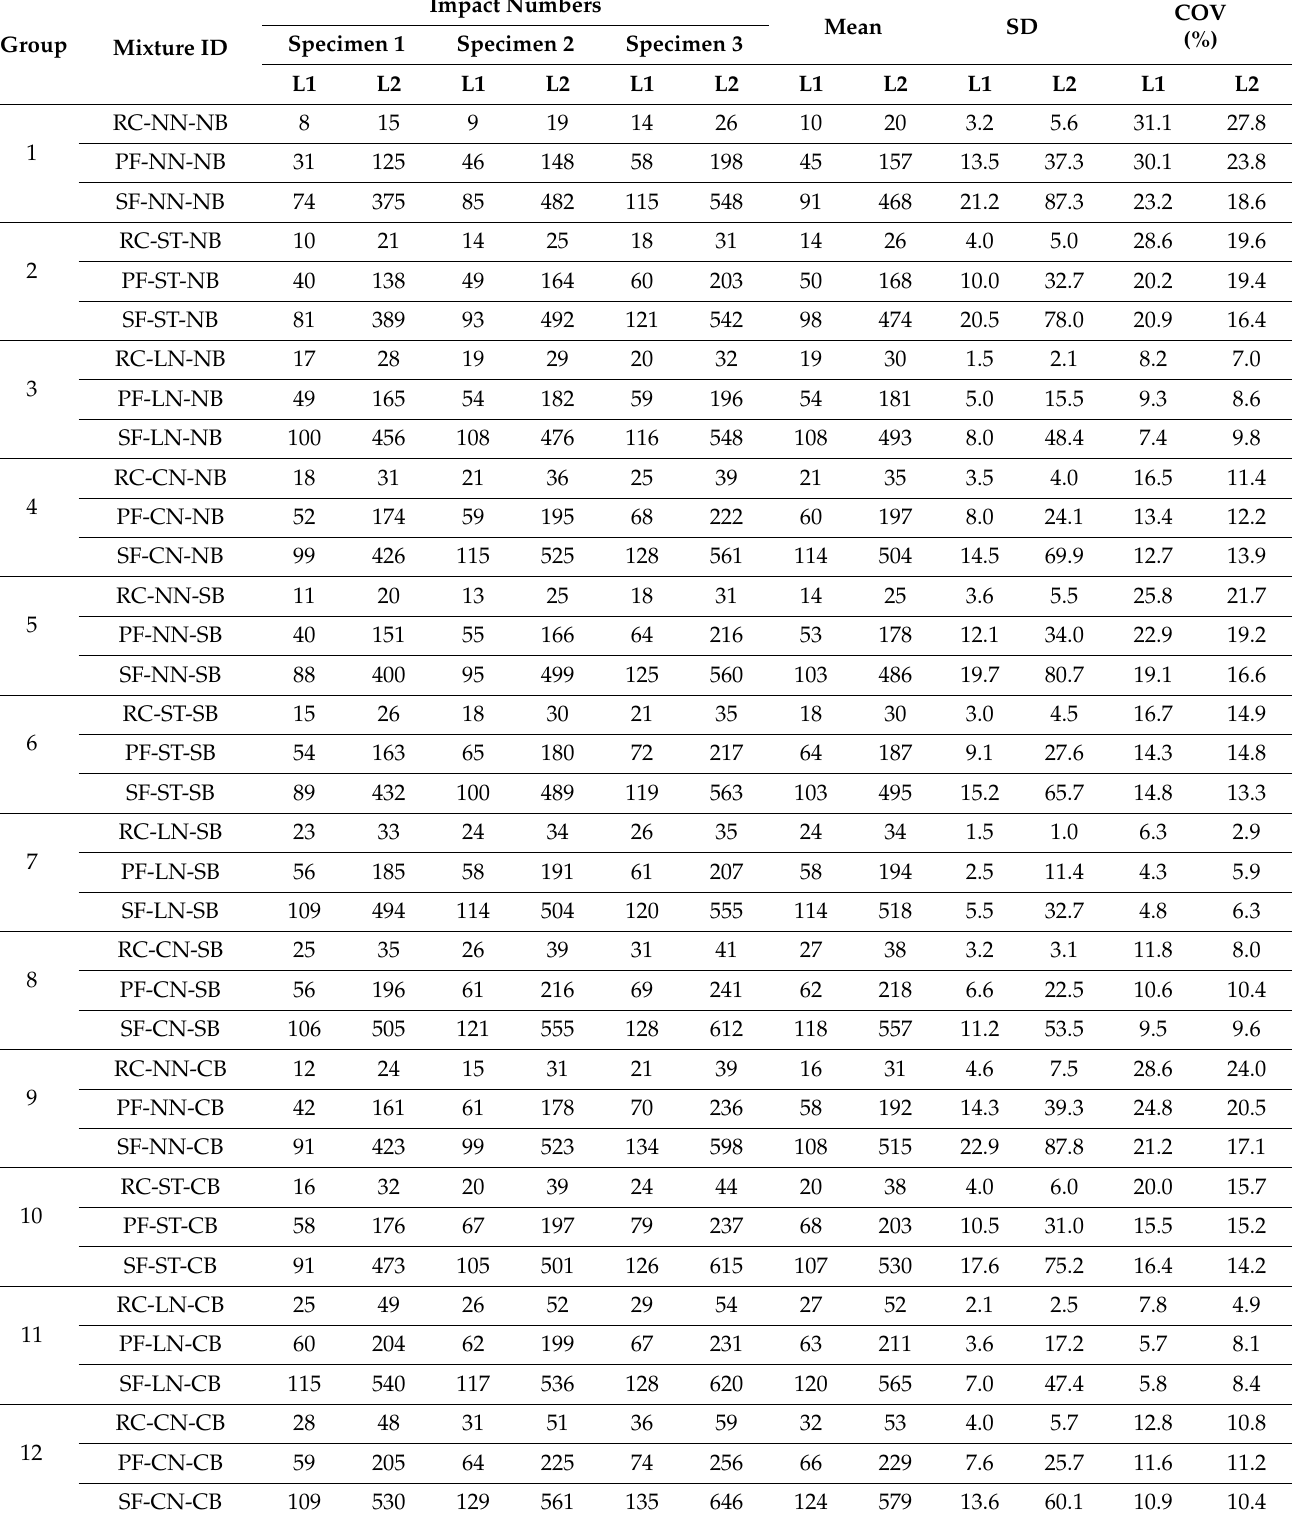
Table 3. Impact test